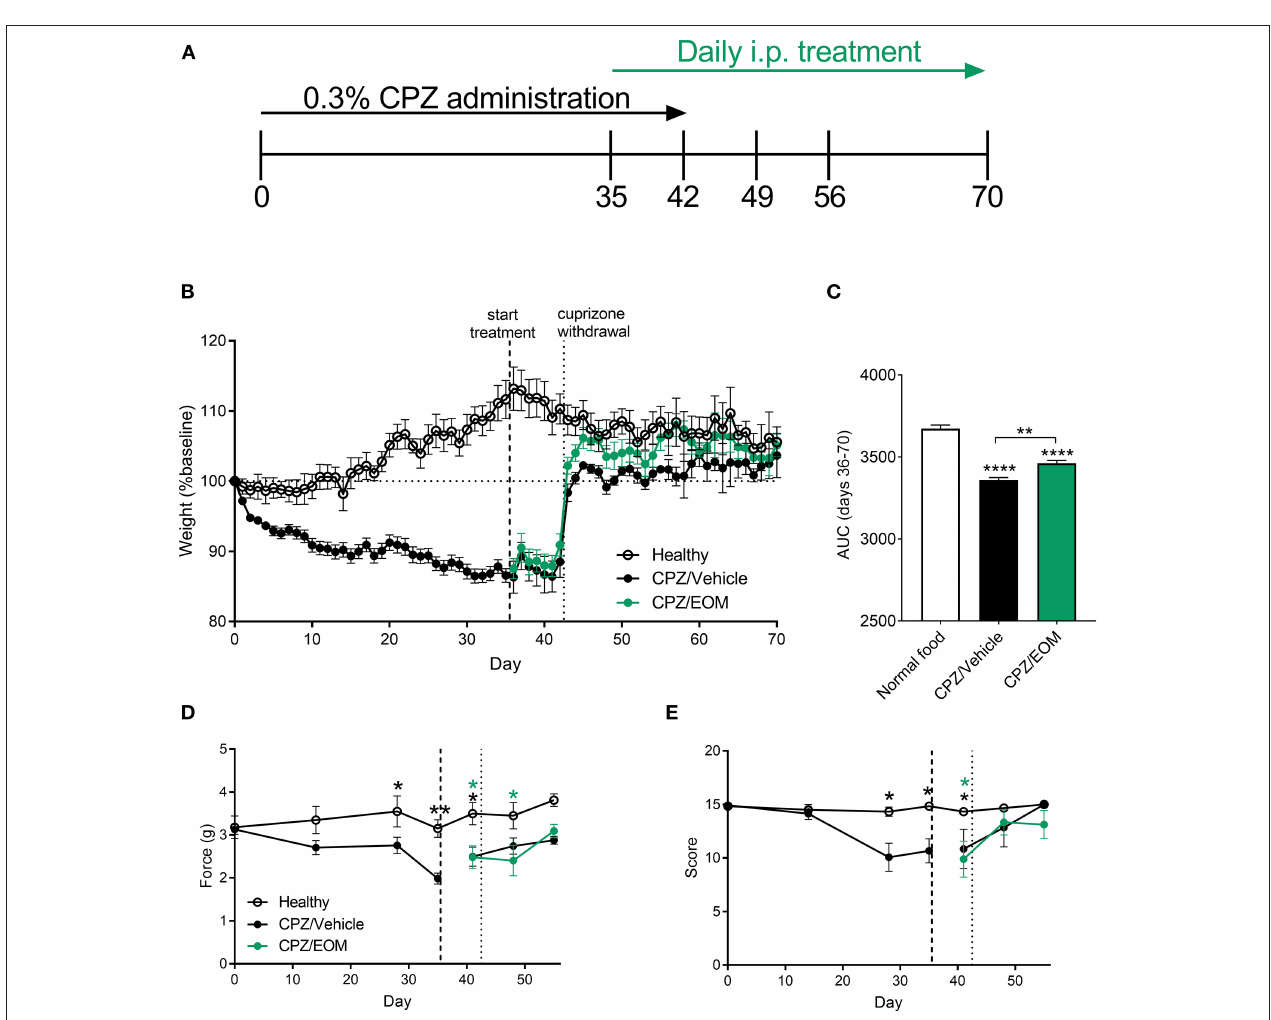
myelin per region of interest, determined using thresholding in luxol fast blue stained spinal cord sections. Results are shown from 3 independent EAE experiments, n = 5–10 animals, two sections of the cervical spinal cord per animal. Kruskal-Wallis with Dunn’s multiple comparison test. Data presented as mean ± SEM. * p <